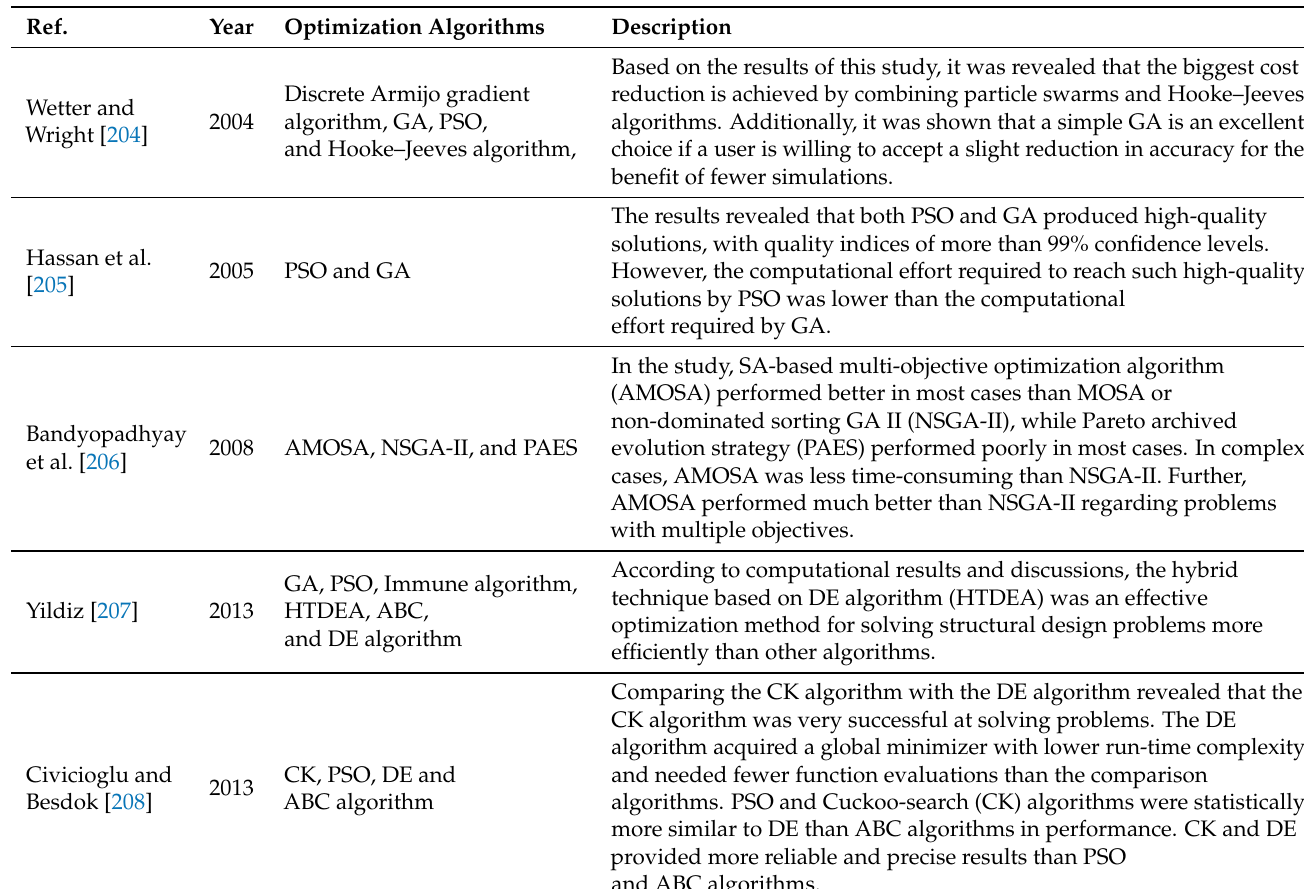
Table 15. Comparison of optimization